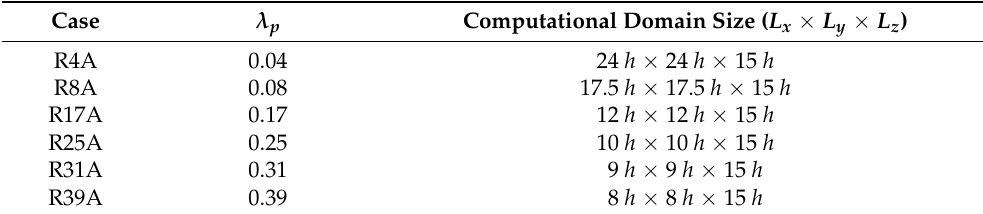
Table 3. List of simulation cases and the computational domain size